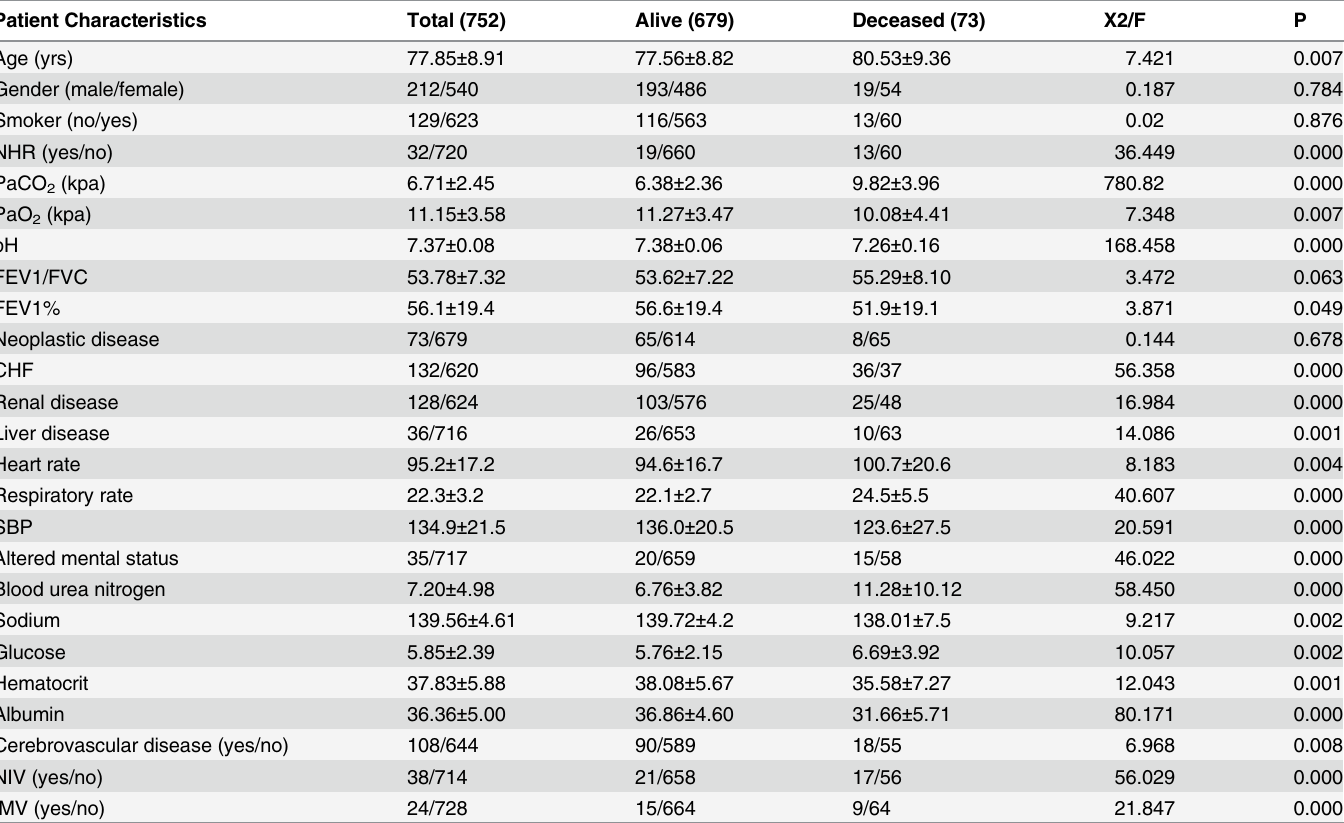
Table 1. Baseline characteristics and survival of patients hospitalized with